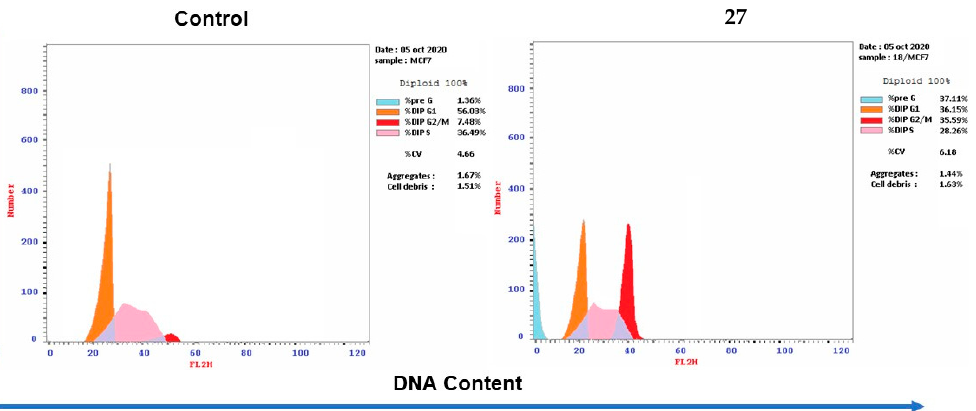
Figure 3. Determination of cell cycle arrest by flow cytometry. Effect of compound 27 on the cell cycle distribution of the MCF-7 cell